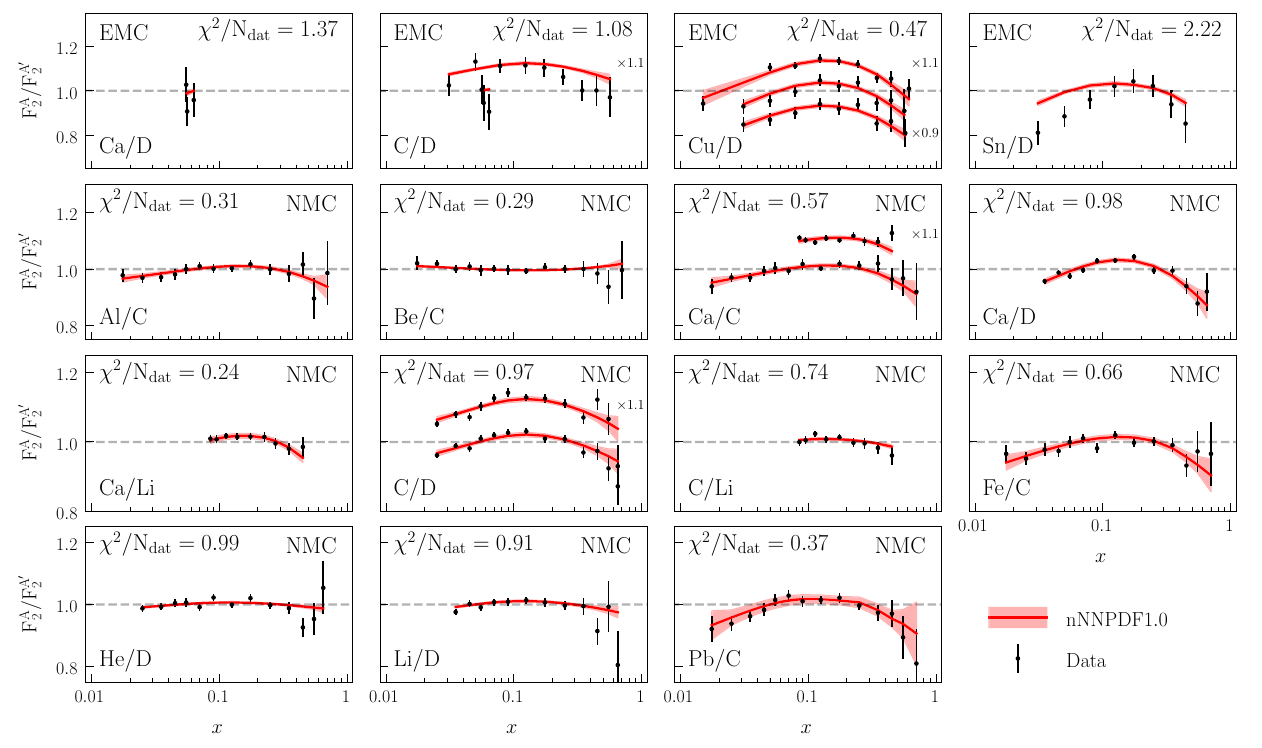
Fig. 13 Comparison between the experimental data on the struc- / F A (cid:17) ture function ratios F A and the corresponding theoretical pre- 2 2 dictions from the nNNPDF1.0 NLO fit (solid red line and shaded band) for the measurements provided by the EMC and NMC exper- iments. The central values of the experimental data points have